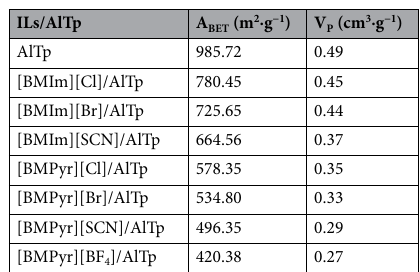
Table 1. Textural characteristics of the samples.